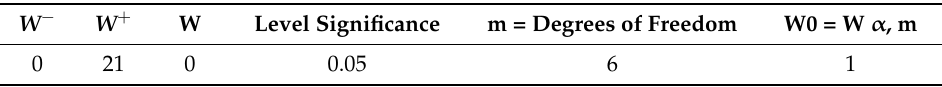
Table 20. Values of parameters for the statistical